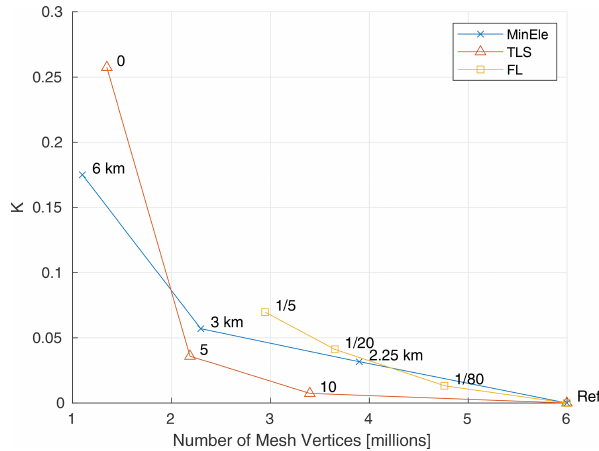
Figure 8. The two-sample Kolmogorov–Smirnov test statistic, K , versus the total number of mesh vertices. K is computed as the largest vertical distance between the RMSE t | tot ECDF curve of the Ref mesh design and the ECDF curve of the coarsened mesh de- signs (varying MinEle, TLS, and FL; Table